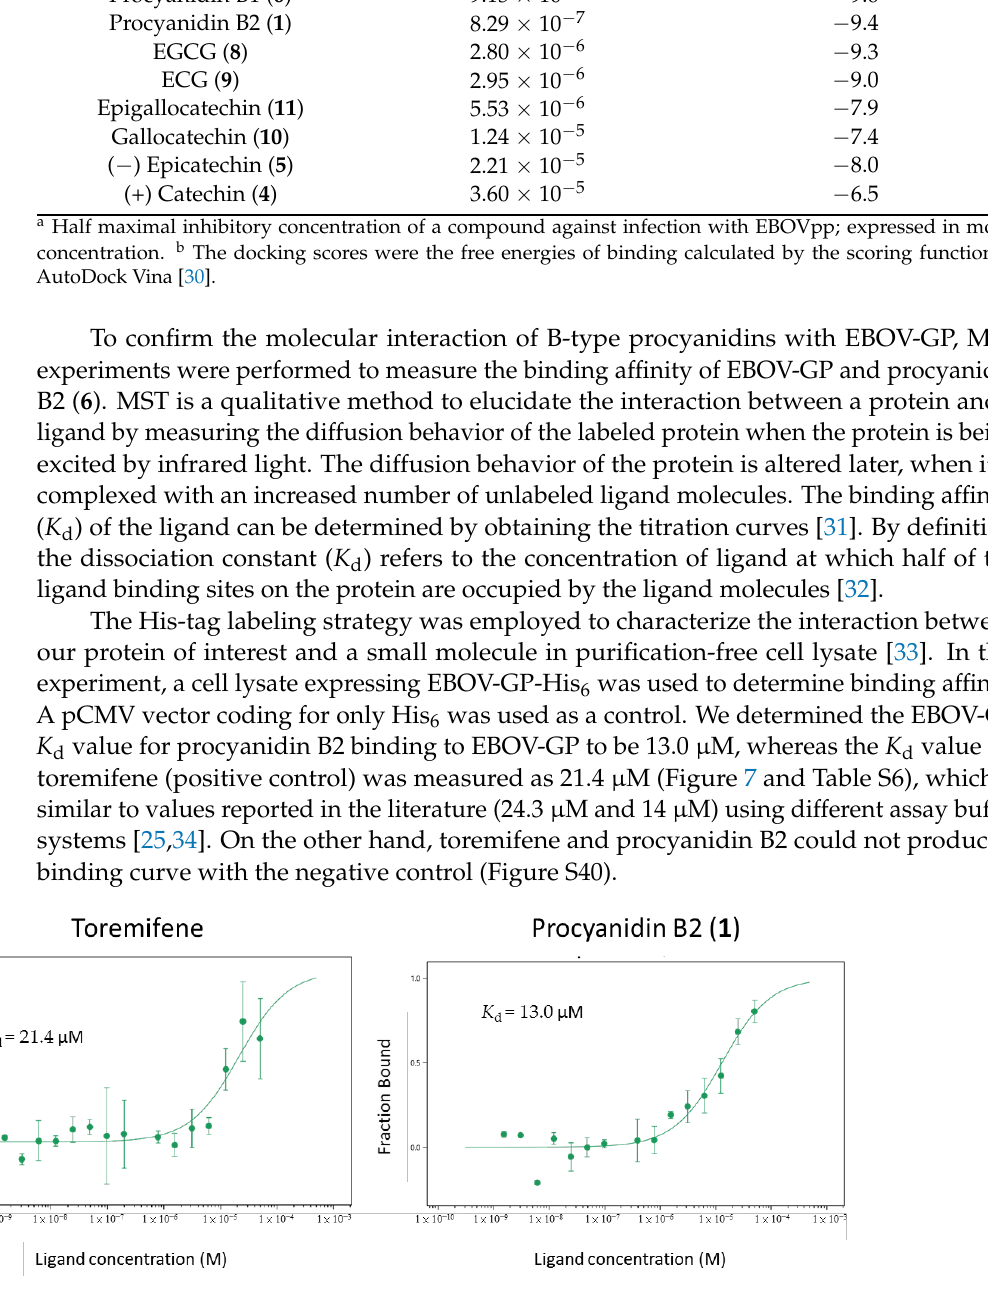
Figure 7. K d values generated for the binding affinities of toremifene and procyanidin B2 ( 1 ) to EBOV-GP using the MST technique. Each experimental compound was run in triplicate.